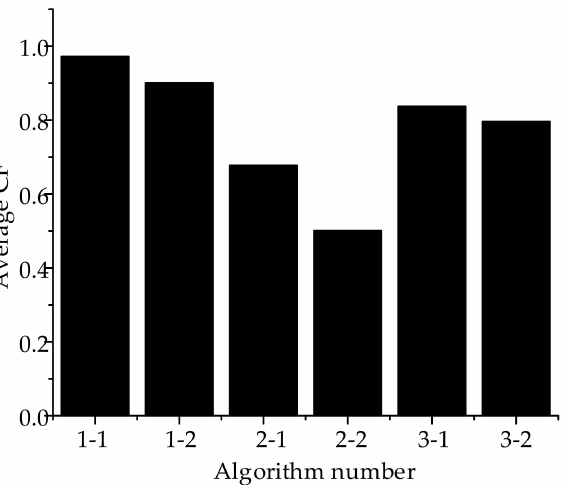
Figure 14. Comparison between AFWA-H-Mine and traditional algorithms of the second